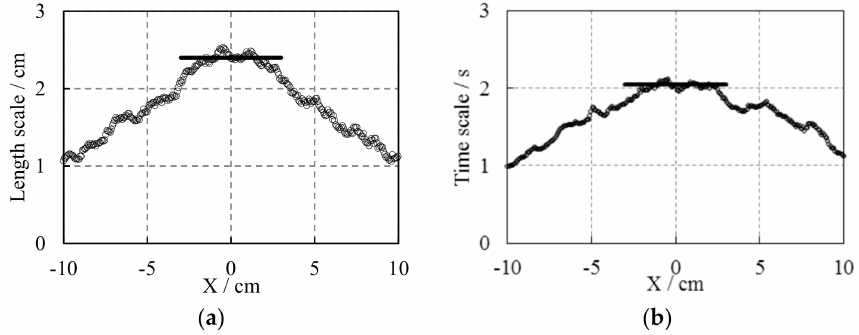
Figure 10. Spatial distribution of the integral scale at di ff erent X position when s = 0.5 cm and f = 3 Hz: ( a ) integral length scale; ( b ) integral time scale.